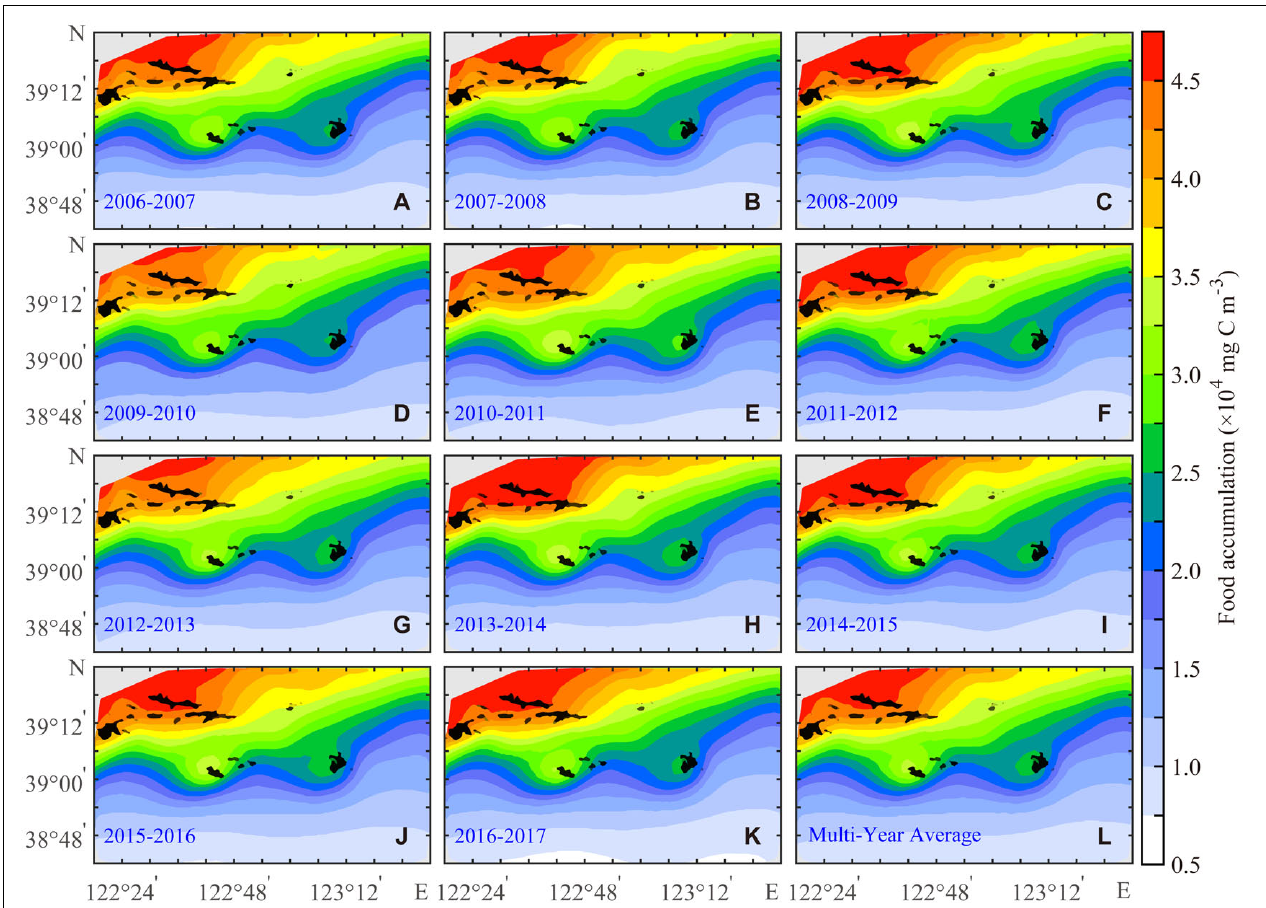
FIGURE 6 | Annual (A–K) and the multiyear average (L) of food accumulation for the Yesso scallop ( P. yessoensis ) in the Changhai sea area, China, from December 1, 2006 to November 30, 2017.